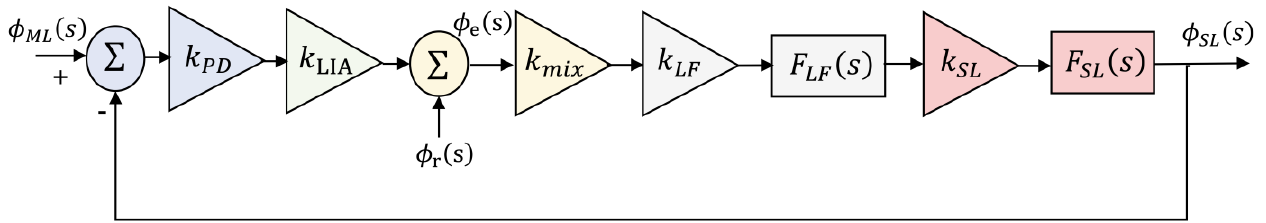
Figure 2. The block diagram of our PIC-based heterodyne OPLL (the definition of each parameter will be shown in paragraph 2 of section 2.1).